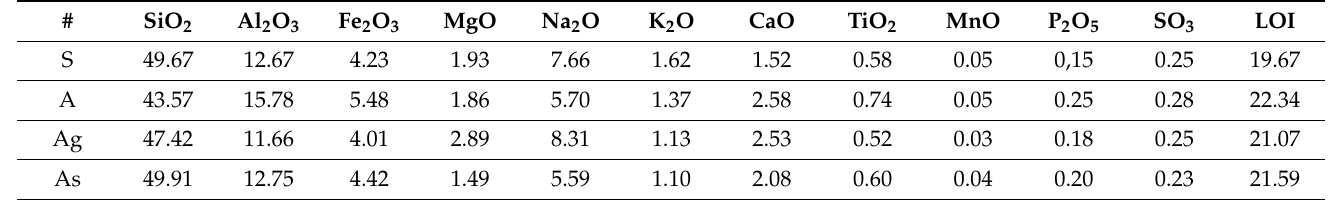
Table 3. Chemical compositions of initial and modified porous geopolymer precursors,